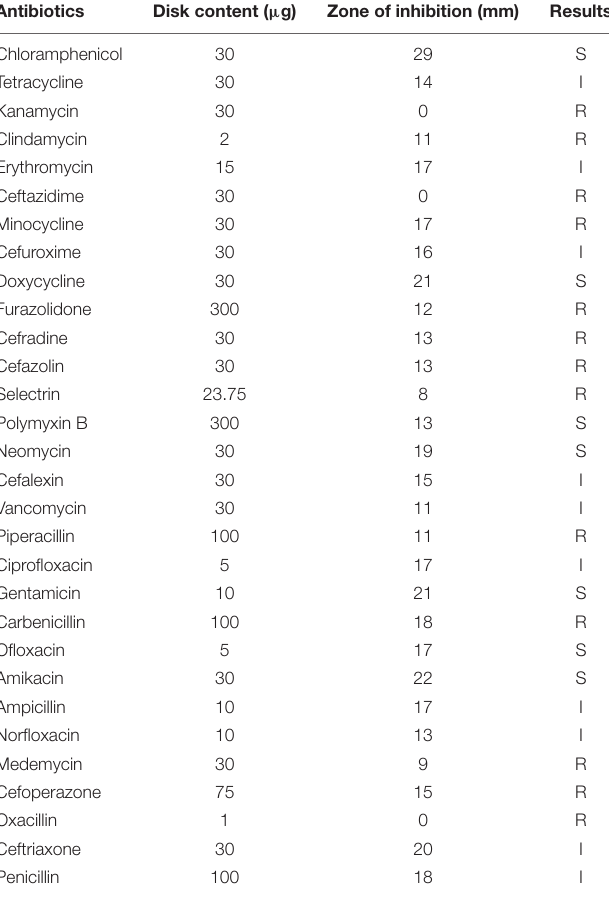
TABLE 3 | Antimicrobial susceptibility of A. lwoffii